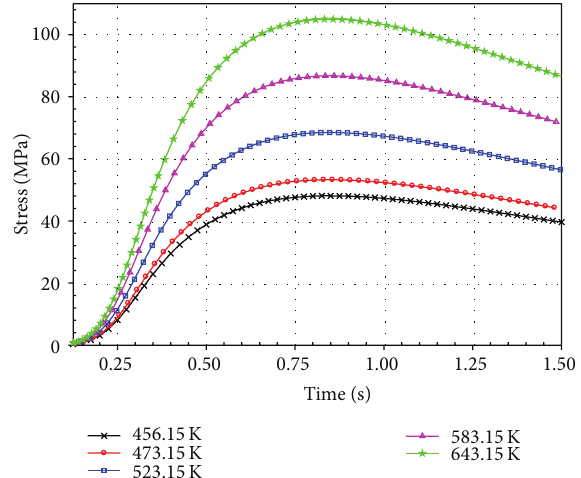
Figure 16: Stress distribution (MPa) on point X.